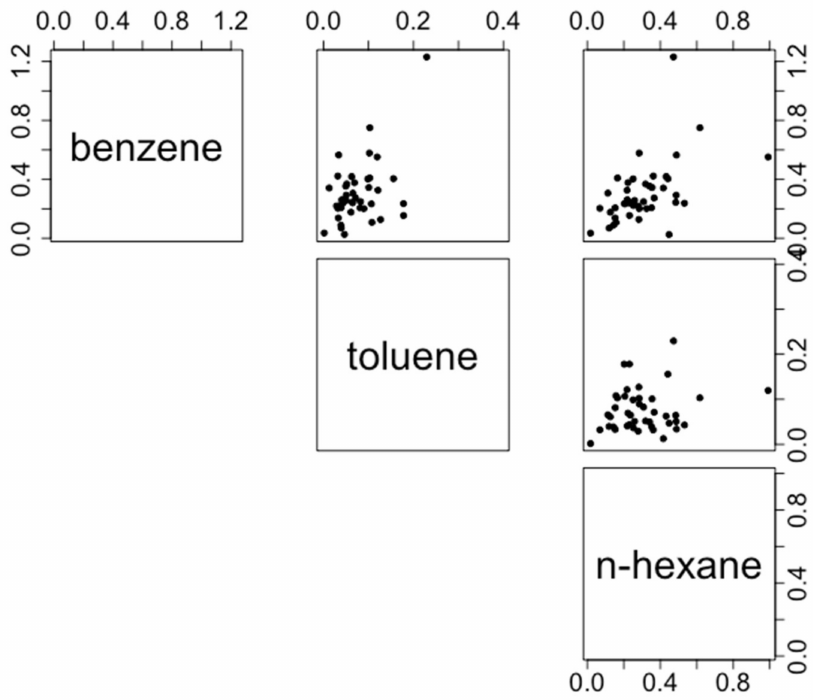
Figure 5. Relationships between aromatics and non-aromatics (in ppb). In this case, Spearman’s rank correlation coe ffi cients ranged from 0.27 (toluene-benzene) to 0.56